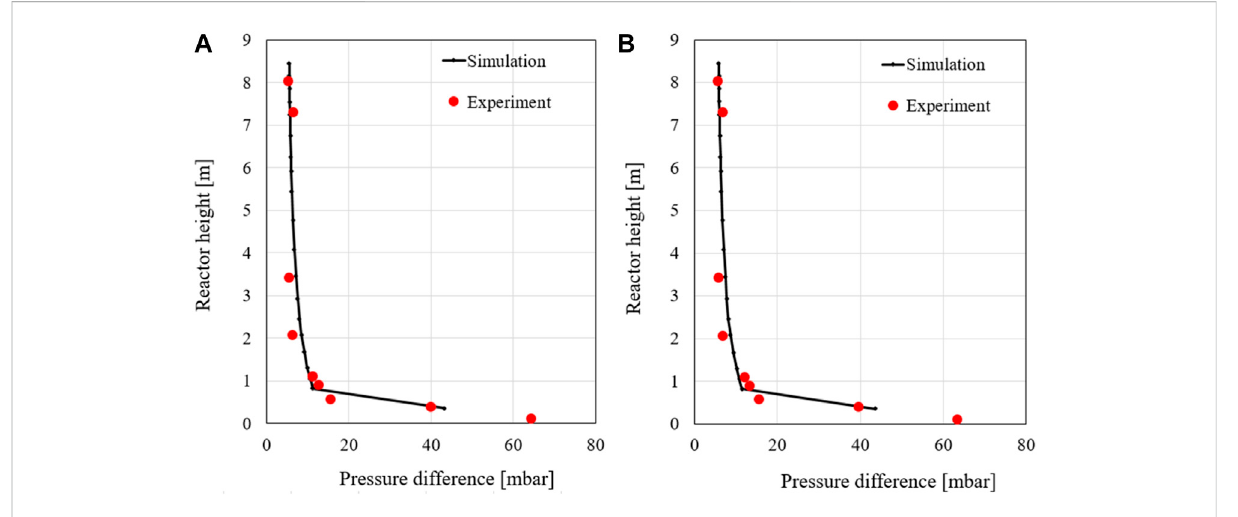
FIGURE 12 Pressure pro fi les at two 80% load cases: the fi rst (A) and the second (B)